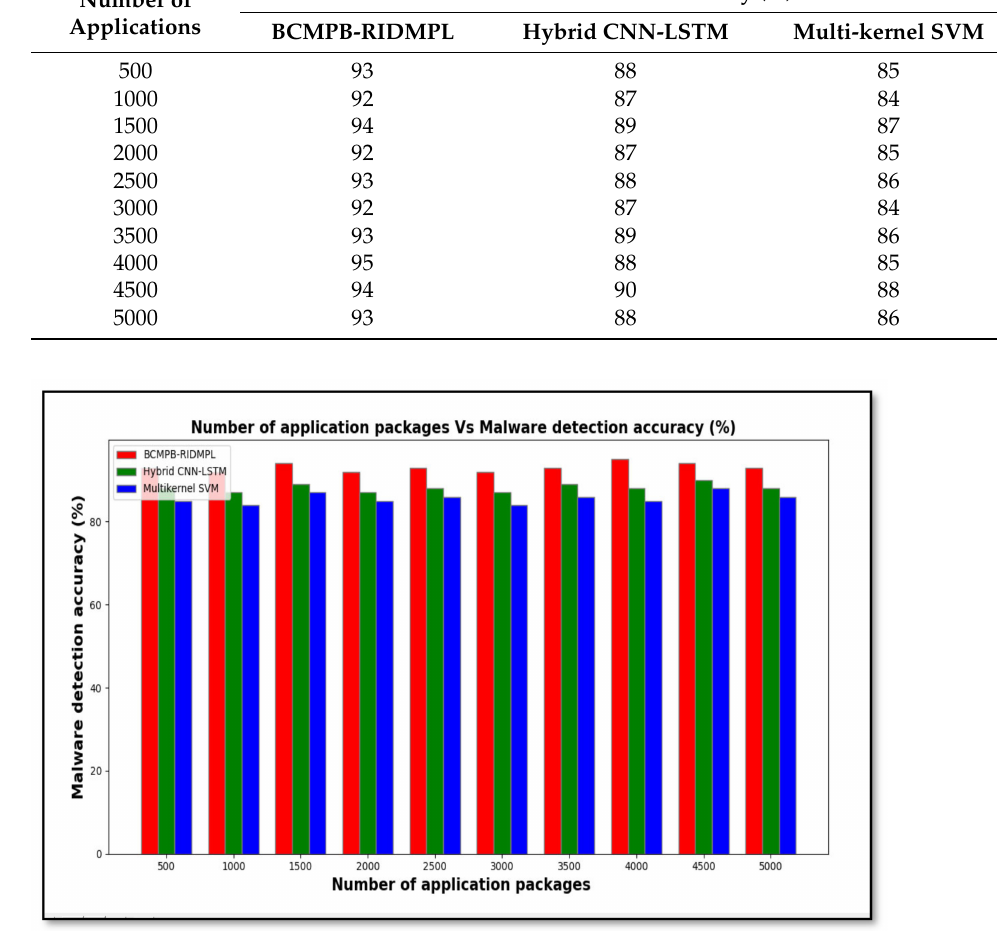
Figure 7. Graphical representation of test of malware detection accuracy for BCMPB-RIDMPL, CNN-LSTM and multi-kernel